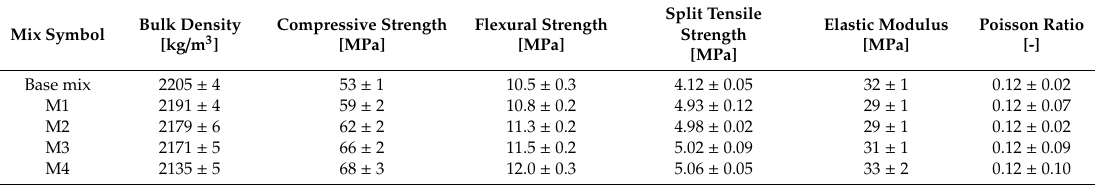
Table 5. Experimental results of material and mechanical properties.